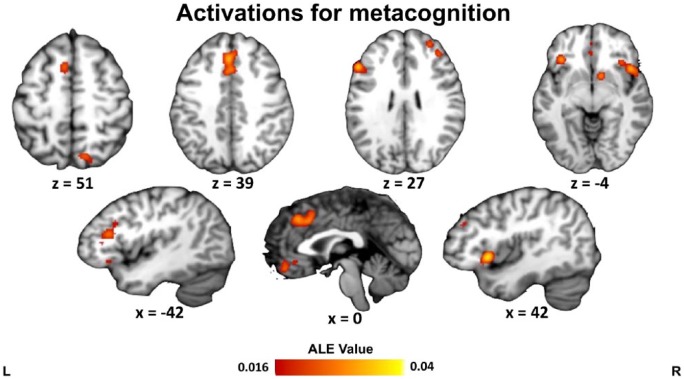
ALE results for all studies on metacognition. Clusters are displayed in
MNI standard space. Multiple-comparisons correction was applied at the
cluster level at a family-wise error-corrected threshold of
p < .05, 5000 permutations, and a
cluster-defining threshold of p < .001
uncorrected.